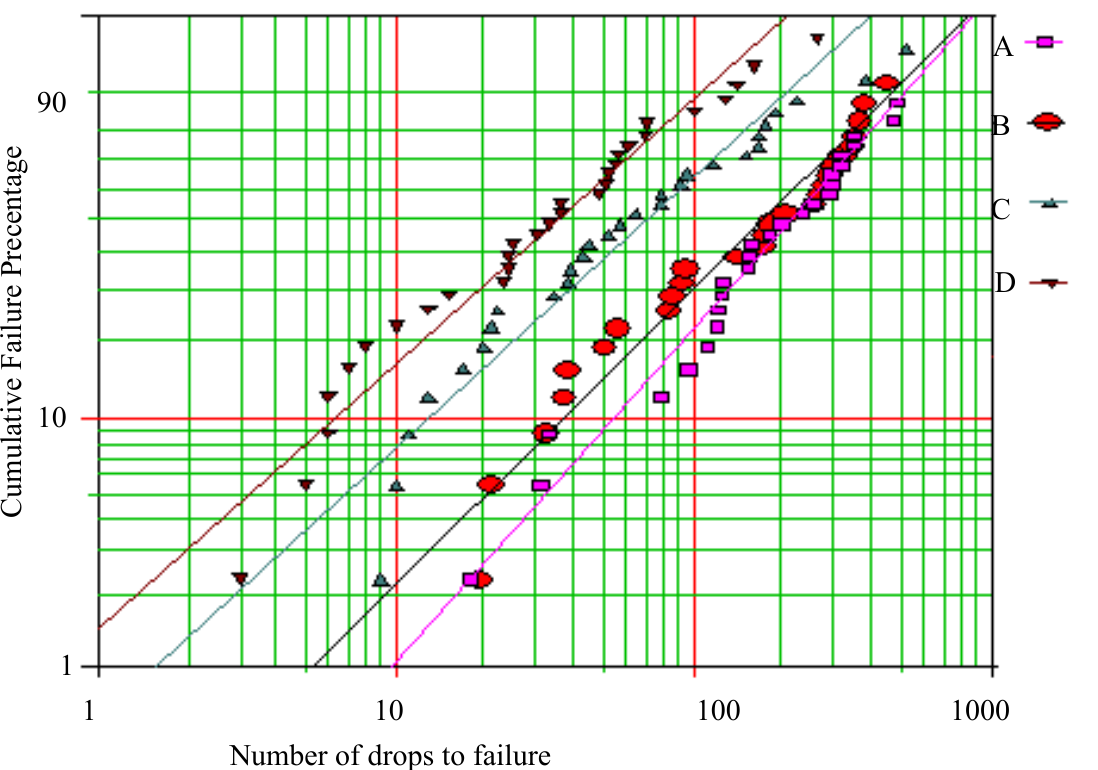
Figure 1. Weibull reliability plots from drop test results of assemblies with the Ni(P)|Au- finished soldering pads having the four different P-